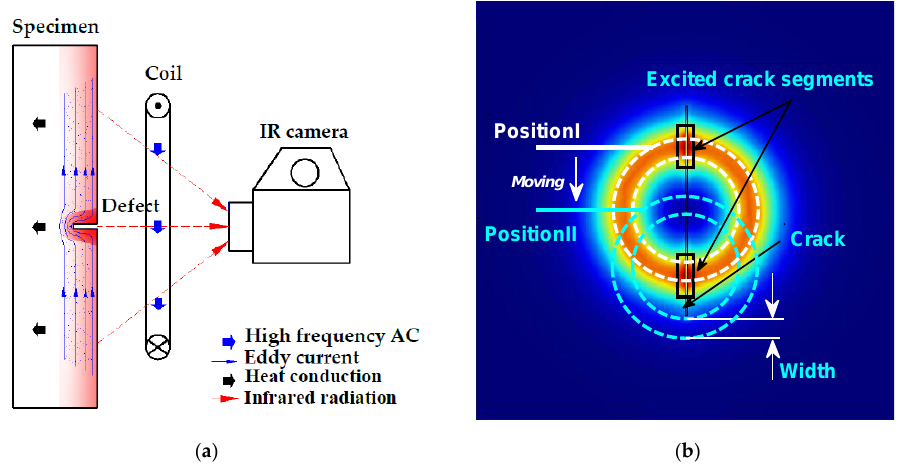
Figure 1. The detection mechanism for cracks on a polycrystalline diamond compact (PDC) bit: ( a ) principle of eddy current pulsed thermography (ECPT); ( b ) temperature distribution excited by an annular coil.